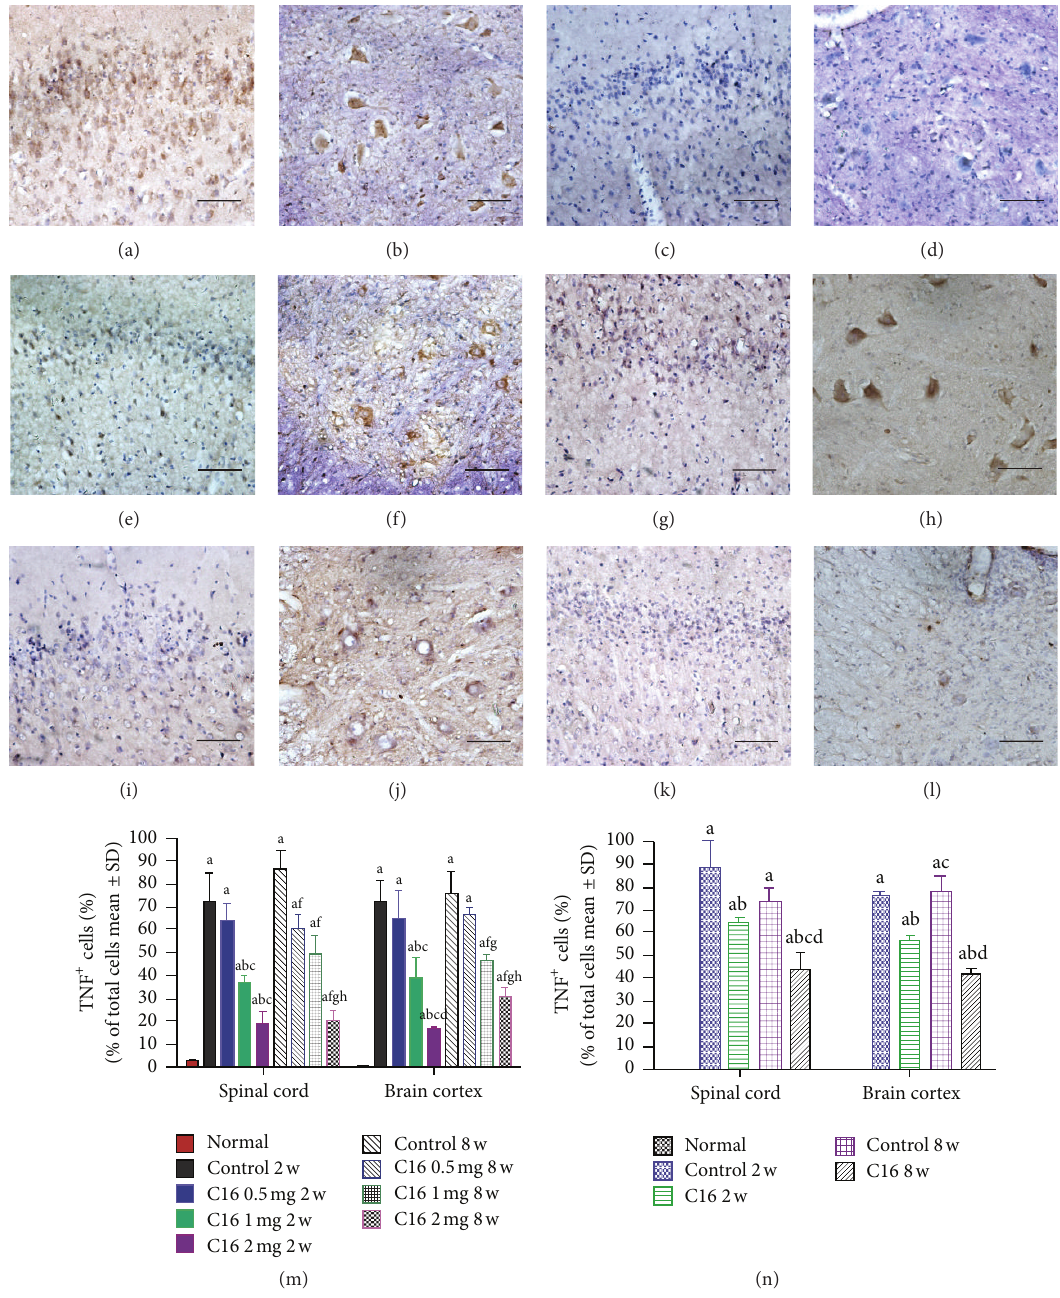
Figure 13: C16 treatment reduced TNF- 𝛼 expression both in spinal cord and brain. TNF- 𝛼 immunostaining, counterstained with hematoxylin; bar = 100 𝜇 m. ((a), (c), (e), (g), (i), (k), and (m) Coronal sections of motor cortex; (b), (d), (f), (h), (j), (l), and (n) traverse section through the lumbar spinal cord). At 2 weeks after immunization: vehicle control rats ((a), (b) plenty of TNF- 𝛼 labeled apoptotic neural cells appeared in motor cortex and spinal cord anterior horn), 2 mg/per day C16 treated EAE rats ((c), (d)), and C16 late treated EAE rats ((e), (f)). At week 8 after immunization, vehicle control rats ((g), (h)), 2mg/per day C16 treated EAE rats ((i), (j)), and C16 late treated EAE rats ((k), (l)). (k) Medium to high-dose C16 treatment reduced TNF- 𝛼 labeled cells at 2 weeks postimmunization group, a 𝑃 < 0.05 versus normal rats; b 𝑃 < 0.05 versus vehicle control rats, c 𝑃 < 0.05 versus 0.5mg/per day C16 treated EAE rats. At week 8 after immunization, f 𝑃 < 0.05 versus vehicle control rats, g 𝑃 < 0.05 versus 0.5 mg/per day C16 treated EAE rats, and h 𝑃 < 0.05 versus 1 mg/per day C16 treated EAE rats. (l) Late treated C16 treatment also decreased TNF- 𝛼 labeled cells to a certain extent. a 𝑃 < 0.05 versus normal rats; b 𝑃 < 0.05 versus vehicle control rats at week 2 after immunization; c 𝑃 < 0.05 versus C16 treated EAE rats at week 2 after immunization; d 𝑃 < 0.05 versus vehicle control rats at week 8 after